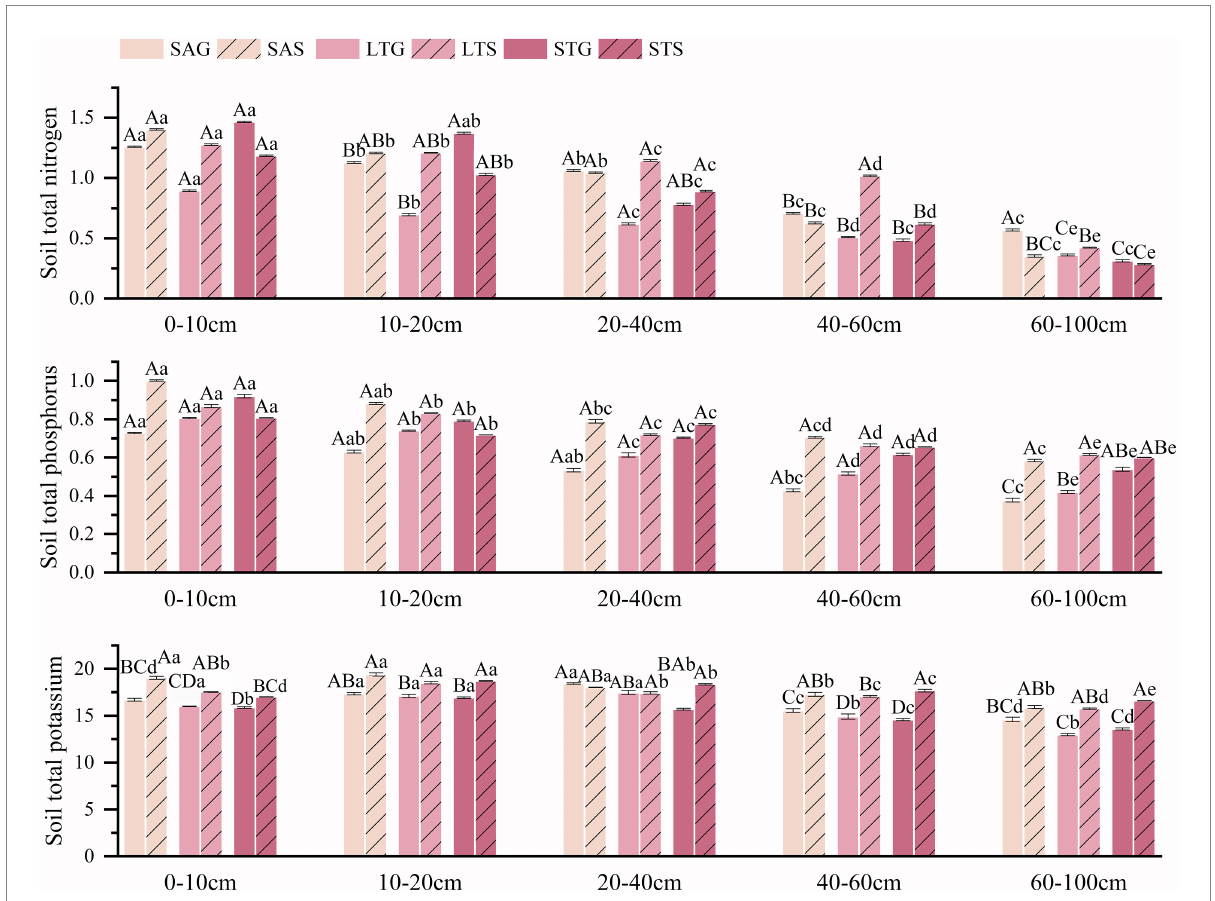
FIGURE 3 Characteristics of soil total nutrients in the 0–100 cm soil profile under three shrub-encroached